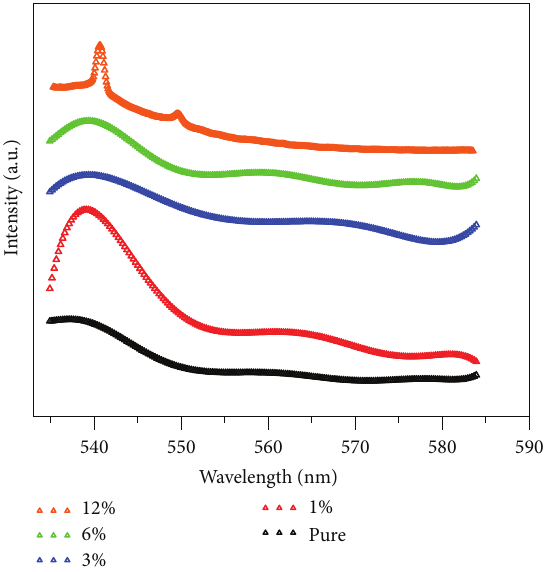
Figure3:PLspectraofCdOfilmsatroomtemperatureasafunction of saccharin concentration.